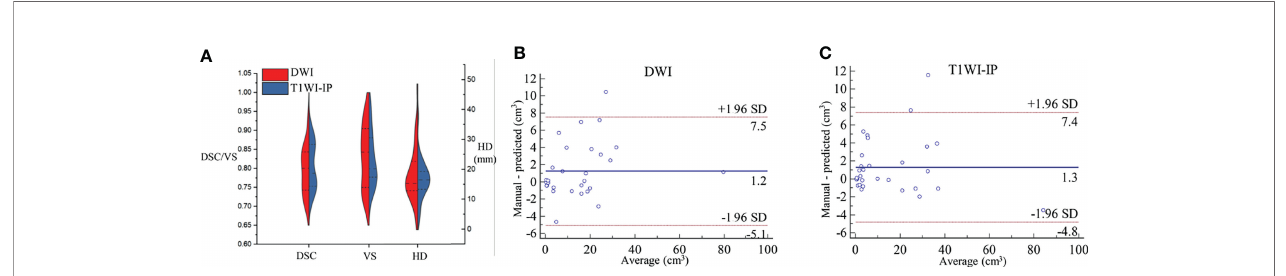
FIGURE 6 | The segmentation accuracy of bone metastases on an external dataset. (A) Split violin plot of DSC, VS, and HD of the bone metastases on DWI and T1WI-IP images. (B) The Bland – Altman plot of the volume difference between manual annotation and model prediction on DWI images. (C) The Bland – Altman plot of the volume difference between manual annotation and model prediction on T1WI-IP images. DSC, Dice similarity coef fi cient; HD, Hausdorff distance; T1WI-IP, T1W images obtained using the Dixon technique with in-phase; VS,